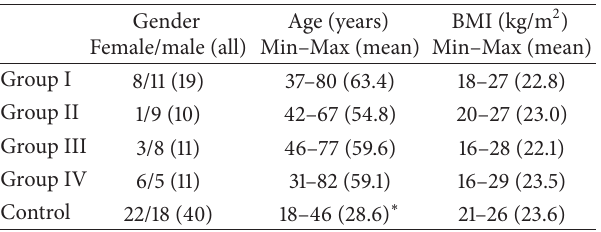
Table 1: Gender, age, and body mass index (BMI) in all groups of patients, and in control